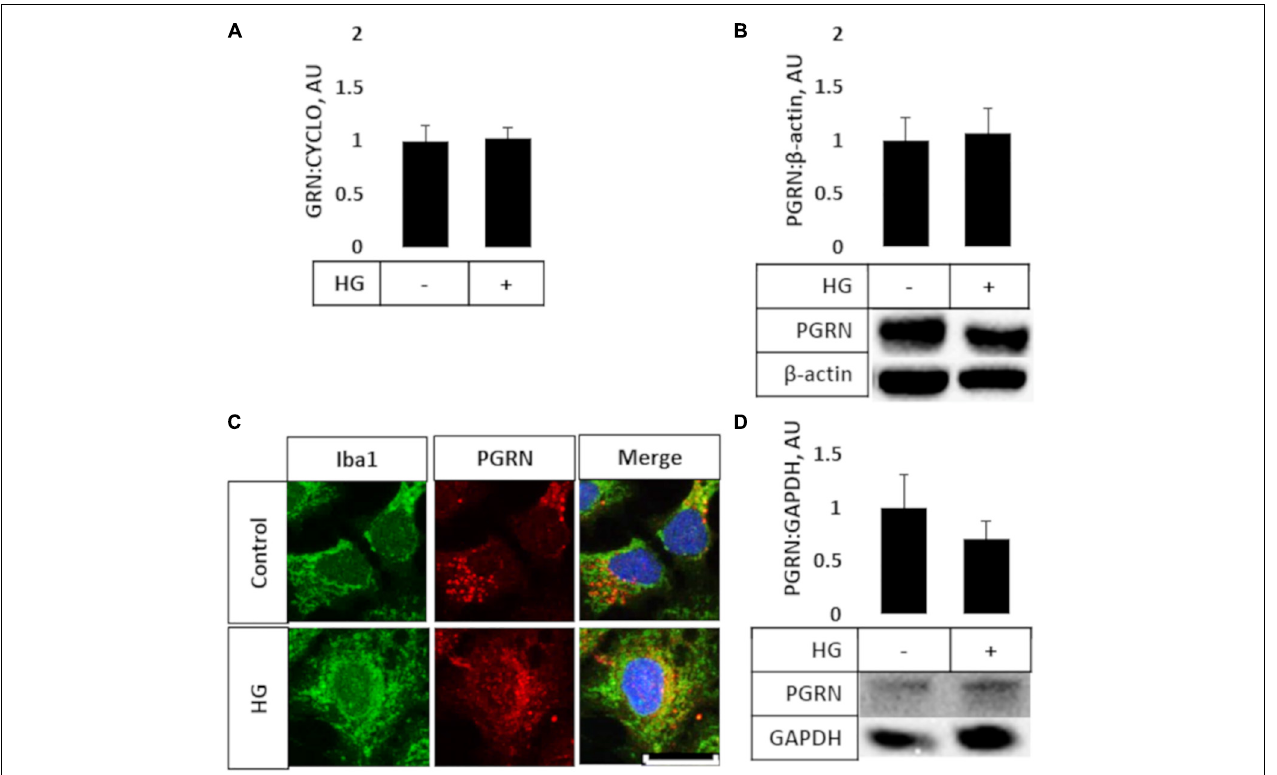
FIGURE 2 | PGRN expression in microglial cells treated with high glucose. HMC3 microglial cells were grown to confluence and treated with high glucose for 72 h before harvest and testing for mRNA (A) and protein (B) levels of PGRN. A, PGRN mRNA levels were unaffected by high glucose, changing from 1.000 ± 0.139 AU to 1.022 ± 0.099 AU. N = 10 samples. (B) PGRN protein levels were unaffected by high glucose, changing from 1.000 ± 0.212 AU to 1.069 ± 0.232 AU. N = 8 samples. (C) Representative immunofluorescence images of primary microglia after 72 h of treatment, with blue as DAPI, green as Iba1, and red as PGRN. Scale bar, 10 µ m. (D) Western blot analysis of primary cortical cells revealed that PGRN levels were unaffected by glucose concentration, changing from 1.000 ± 0.315 AU to 0.714 ± 0.163 AU. N = 6